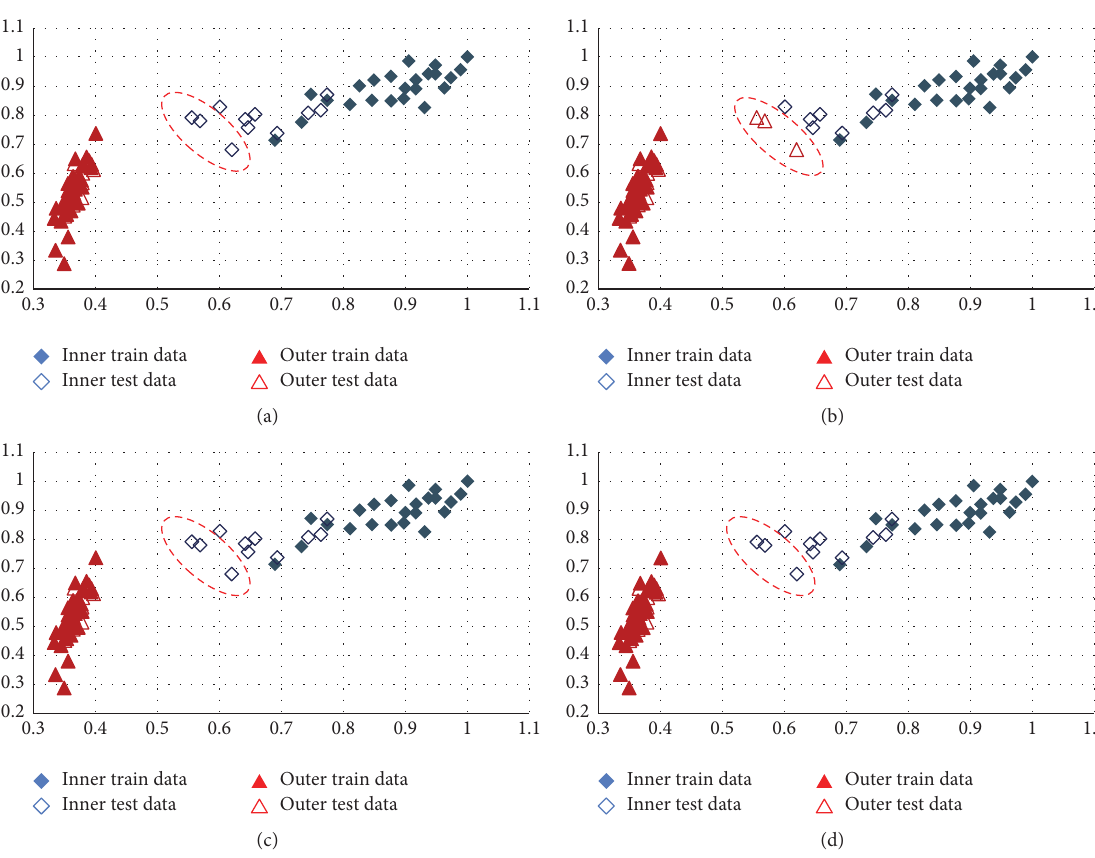
Figure 9: Classification of inner race fault samples from dataset 1 using the traditional k -NN classifier (a) with 𝑘 = 3 and (b) with 𝑘 = 7 and using the proposed 𝑘 -NN classifier (c) with 𝑘 = 3 and (d) with 𝑘 = 7 .